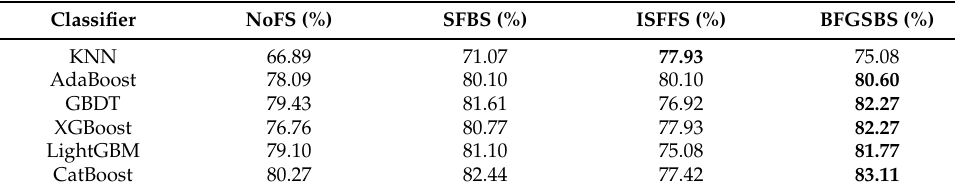
Table 10. Influence of different strategies on the classification accuracy.